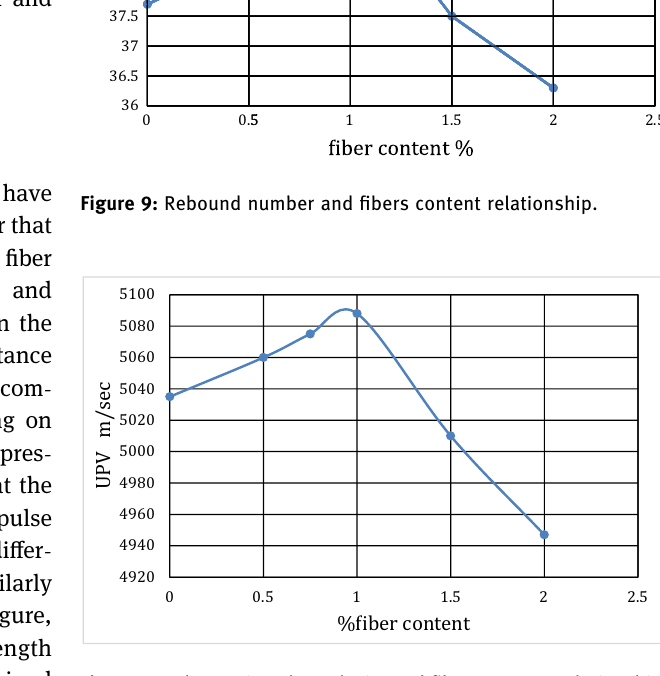
Figure 10: Ultrasonic pulse velocity and fi bers content